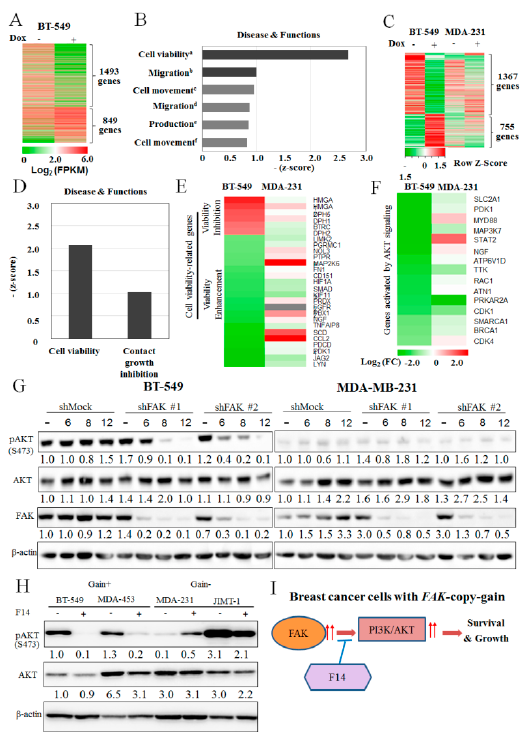
Figure 4. Downstream molecular pathways in FAK-copy-gain cancer cells by FAK knockdown. ( A ) Di ff erentially expressed genes (DEGs) by RNA sequencing in BT-549 Tet-on-shFAK cells with (Dox, + ) or without doxycycline treatment (Dox, -) for 6 days. Genes whose expression changed more than two-fold are shown. The gene list is presented in Table S2. ( B ) Major pathways in DEGs by core analysis using IPA. Suppressed signal pathways by FAK knockdown were related to cell viability and migration. The pathways with more than 0.8 absolute values of z-score are shown. a; cell viability of breast cancer cell lines, b; migration of tumor cell lines, c; cell movement of tumor cell lines, d; migration of breast cancer cell lines, e; production of reactive oxygen species (ROS), f; cell movement of breast cancer cells. ( C ) Di ff erential DEG patterns between BT-549 and MDA-MB-231 by FAK knockdown. The gene list is also presented in Table S3. ( D ) Analysis of BT-549-specific DEGs by IPA. The most suppressed BT-549-specific pathways were related to cell viability rather than to cell migration or movement by FAK knockdown. ( E ) Gene list of BT-549-specific DEGs. Among the BT-549-specific DEGs, genes related to inhibition of viability were upregulated and those associated with increased viability were downregulated by knockdown of FAK. ( F ) BT-549-specific downregulation of genes was activated by AKT signaling by knockdown of FAK. AKT downstream genes were consistently downregulated in BT-549 cells by FAK knockdown but not in MDA-MB-231 cells. The color scales of DEGs for E and F are the same. ( G ) BT-549-specific reduction of AKT phosphorylation by FAK knockdown on Western blot analysis. FAK knockdown reduced AKT phosphorylation in BT-549 cells but not in MDA-MB-231 cells. Cells stably expressing doxycycline-inducible FAK shRNAs (shFAK#1 or shFAK#2) or mock shRNA (shMock) were treated with ( + Dox, 1 µ g / mL) or without doxycycline (-Dox) for 6 days. AKT, AKT phosphorylation (pAKT), and FAK were analyzed by Western blotting analysis. β -actin was used as a loading control. ( H ) Reduction of AKT phosphorylation by F14 treatment in FAK-copy-gain cells. After F14 treatment (10 µ M, 6 h), AKT, AKT phosphorylation (pAKT), and FAK were analyzed. AKT phosphorylation was reduced only in FAK-copy-gain cells (BT-549 and MDA-MB-453) but not in cells without FAK-copy-gain (MDA-MB-231 and JIMT-1). MDA-453, MDA-231 and MDA-468 in cell line list are MDA-MB-453, MDA-MB-231 and MDA-MB-468, respectively. ( I ) Proposed model. In breast cancer, cells with FAK-copy-gain are dependent on FAK activity for activation of PI3K / AKT signaling and cell survival. The e ff ect of the FAK inhibitors can be more e ff ective when treating breast cancer patients with FAK-copy-gain. The numbers below the blot images in G and H indicate the relative expression normalized by β